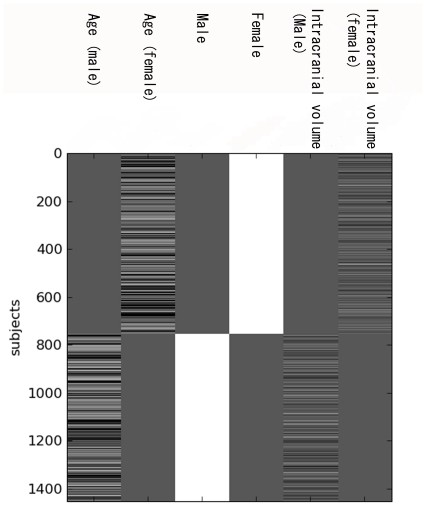
Design matrix of regional gray matter volume using statistical parametric mapping.